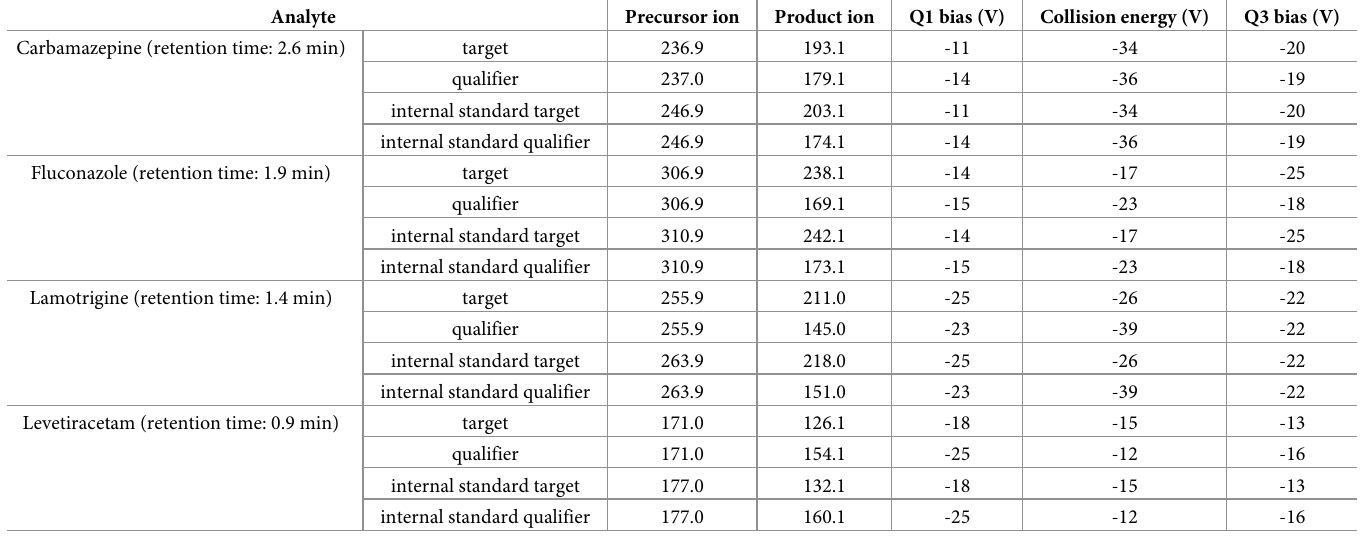
Table 1. Mass spectrometry settings applied for the quantitation of carbamazepine, fluconazole, lamotrigine and